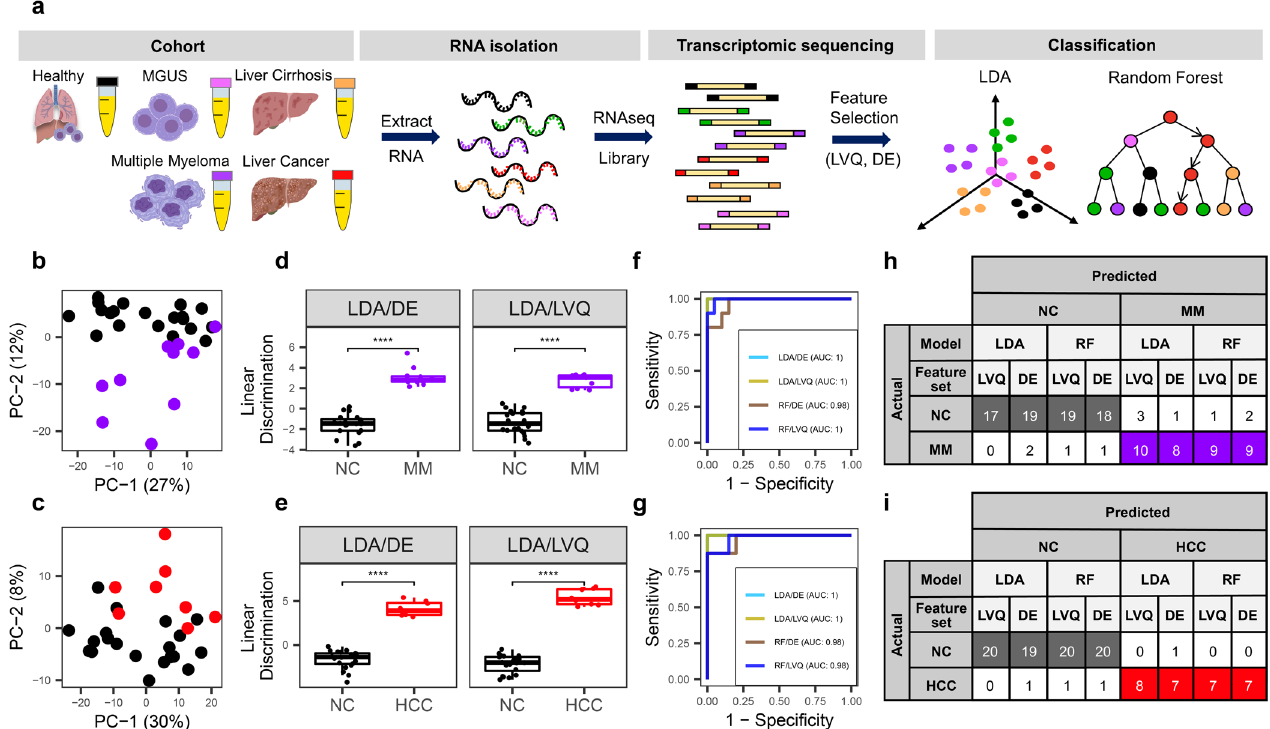
Fig. 1 cfRNA pro fi les distinguish between cancer vs. healthy donors. a Schematic overview of the cfRNA pro fi ling work fl ow starting from plasma collected from the patients and NC donors in EDTA-coated tubes, cfRNA extraction, sequencing, feature selection, and classi fi cation. b , c PCA analysis using the top 500 genes with the largest variance across NC and MM ( b ) or HCC samples ( c ). d , e Linear discriminant analysis (LDA) using DE genes with p adj <0.01 and top ten most important genes identi fi ed by LVQ analysis. P value is derived from the Wilcoxon test. Center-line indicates the median value across all patients in that group, and the hinges represent the lower (Q1) and upper (Q3) quartile, with whiskers extending to the minimum and maximum of the resulting distribution. f , g ROC curves of the two classi fi cation models LDA and Random Forest (RF) model with two feature sets DE and LVQ. h , i LOOCV with the two models LDA and RF with two feature set DE and LVQ. DE genes are listed in Supplementary Table 3 and LVQ genes are listed in Supplementary Table